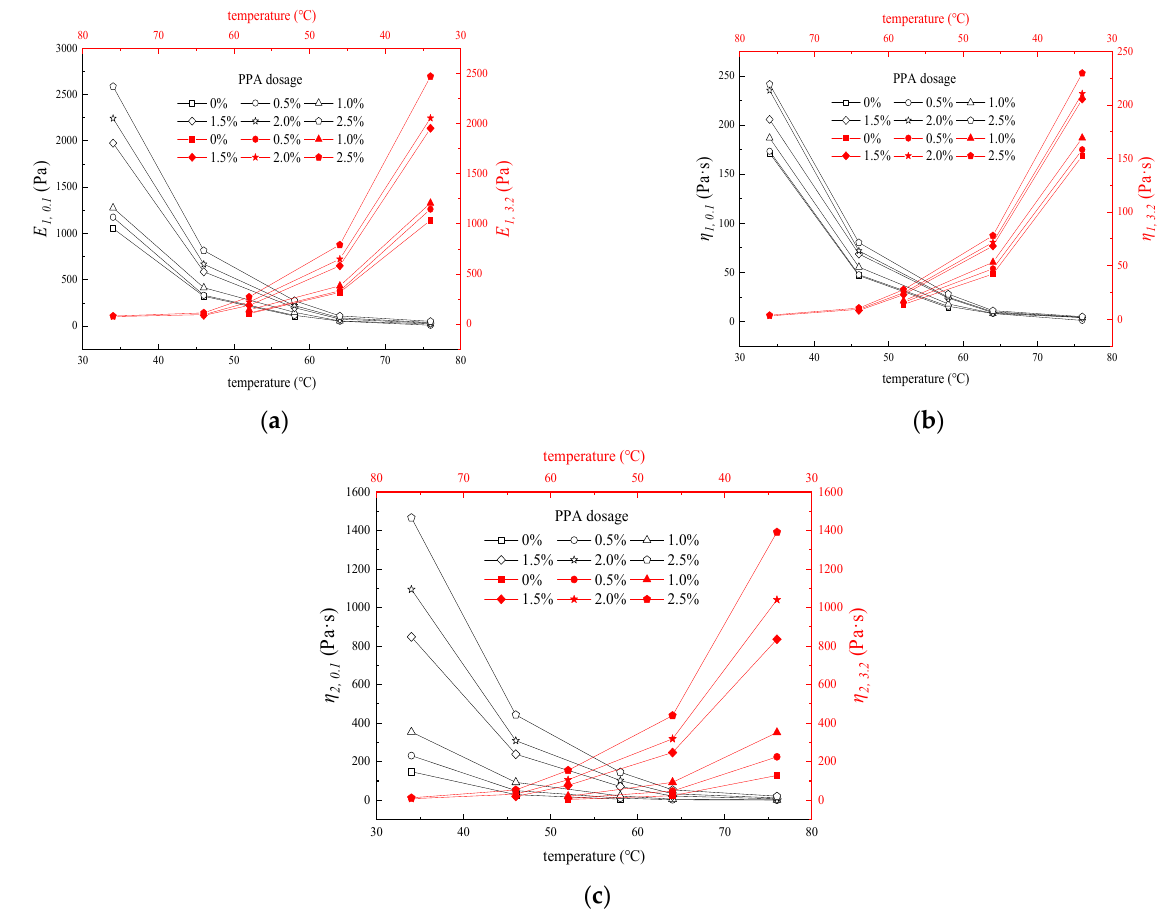
Figure 8. Fi tt ing results at di ff erent temperatures and PPA dosage ( a ) 𝐸 (cid:2869) under di ff erent conditions, Figure 8. Fitting results at different temperatures and PPA dosage ( a ) E 1 under different conditions, ( b ) 𝜂 (cid:2869) under di ff erent conditions, and ( c ) 𝜂 (cid:2870) under di ff erent conditions. ( b ) η 1 under different conditions, and ( c ) η 2 under different